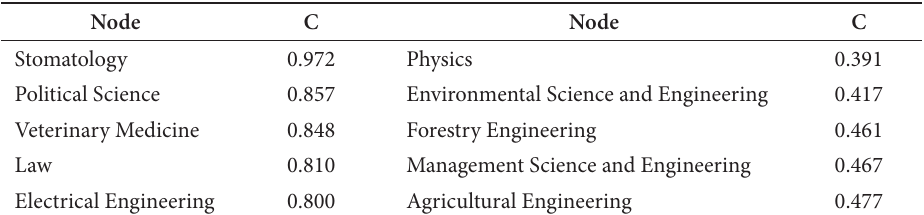
Table 6. Clustering coefficients of some nodes in network